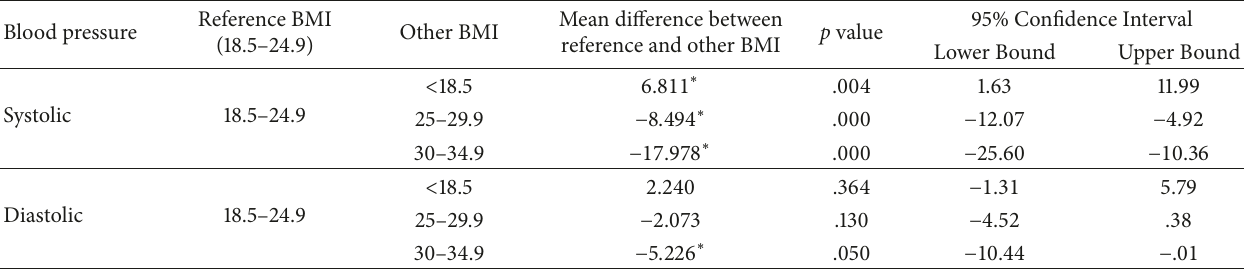
Table 4: Differences in mean systolic and diastolic blood pressure between normal BMI (reference) and other BMI categories. The “ 𝑝 value” indicates the significant level of the mean difference, as significant levels with 𝑝 values < 0.05 are annotated with ∗